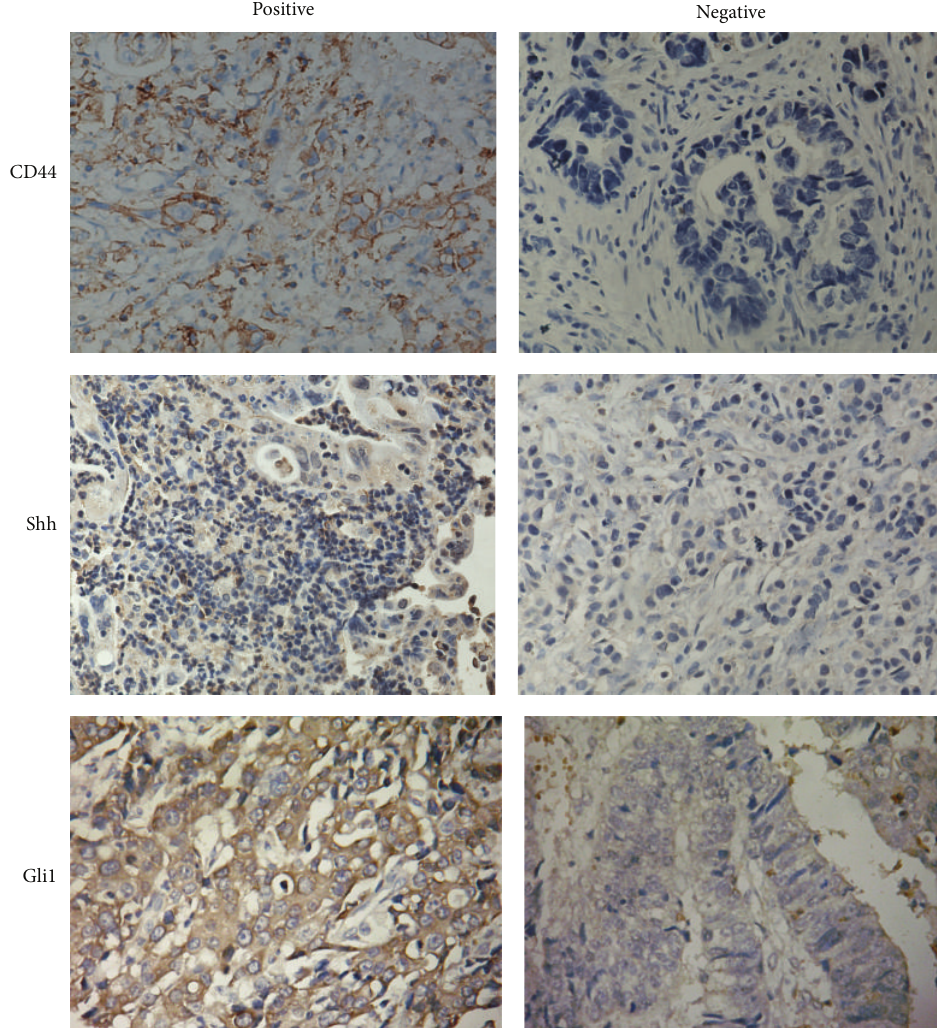
Figure 1: Immunohistochemical expressions of CD44, Shh, and Gli1